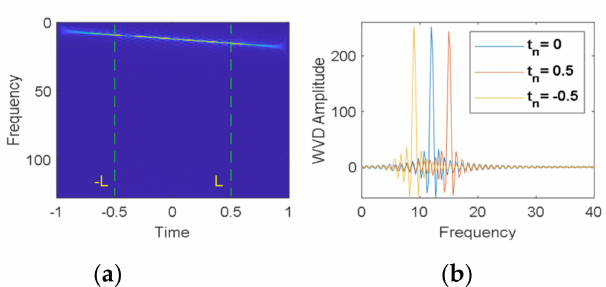
Figure 5. WVD of chirp signal with an initial frequency f 0 = 12, chirp rate k = 6. ( a ) is TF distribution of the signal, ( b ) is frequency distribution at discrete time 0.5, 0 and − 0.5 in ( a